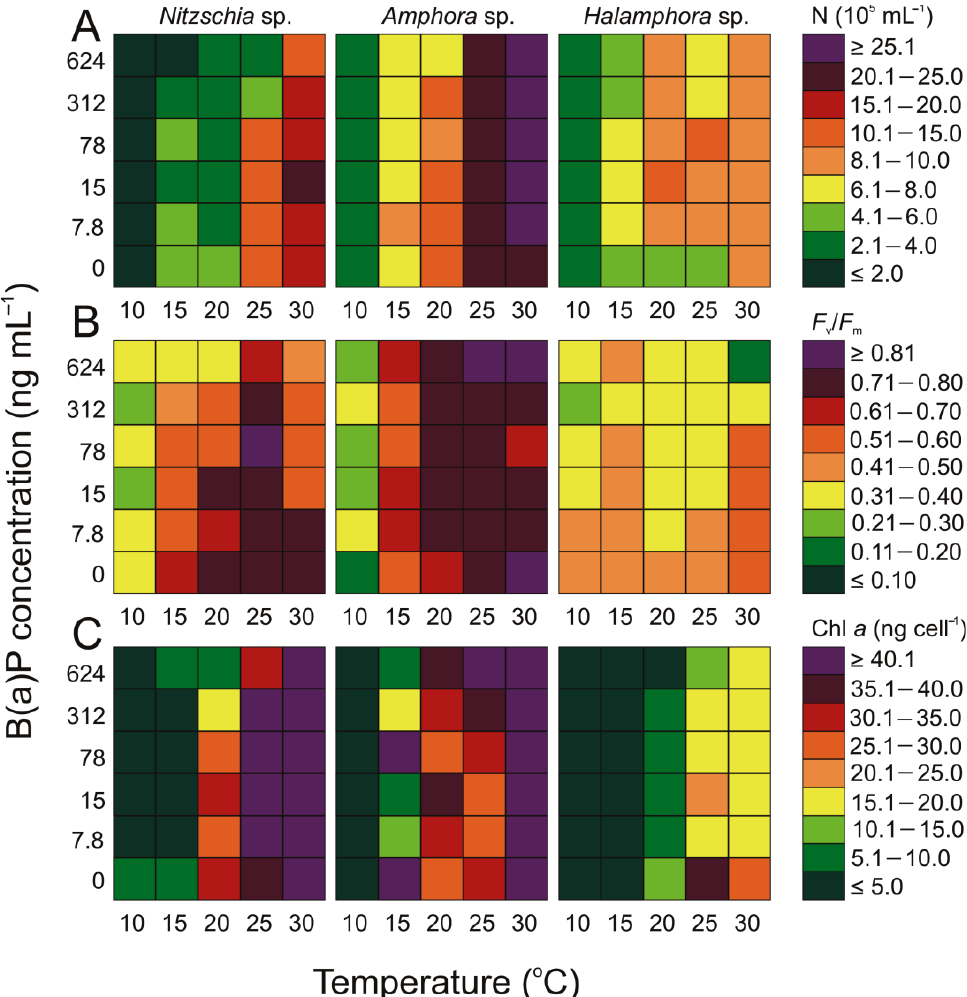
Figure 2. Changes in ( A ) the number of cells (10 5 N mL − 1 ), ( B ) maximum quantum efficiency of PSII photochemistry ( F v / F m ), and ( C ) chl a content (ng cell − 1 ) for airborne diatoms obtained after 7 days of experiment under different B(a)P concentration (ng mL − 1 ) and temperature ( ◦ C) conditions. The green algae selected for the experiment ( Oocystis sp., Coccomyxa sp., Kirchner- iella sp.) exhibited an increase in cell numbers upon the addition of B(a)P (ANOVA,